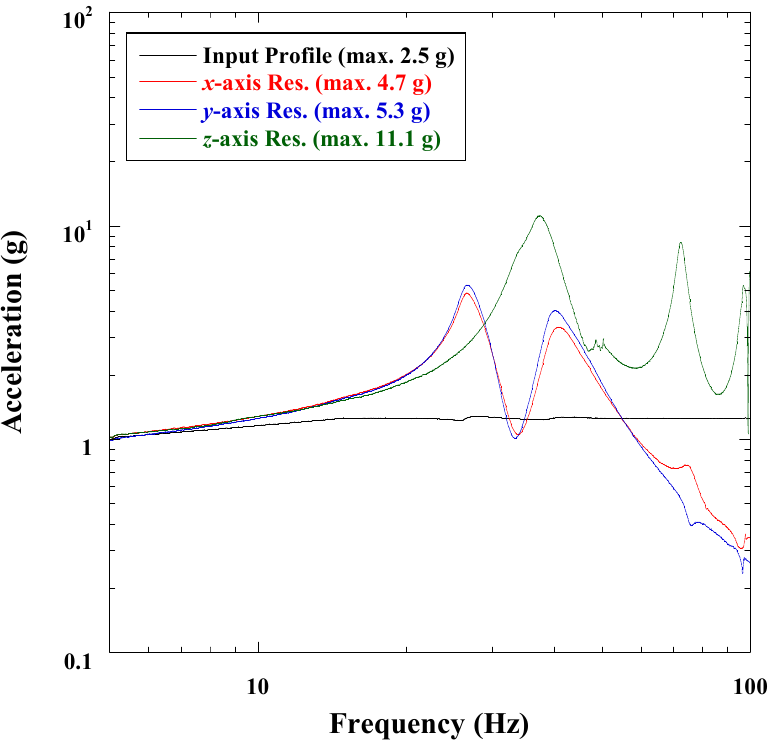
Figure 6. Sine-Vibration Test Results for x- , y- , and z- axes.